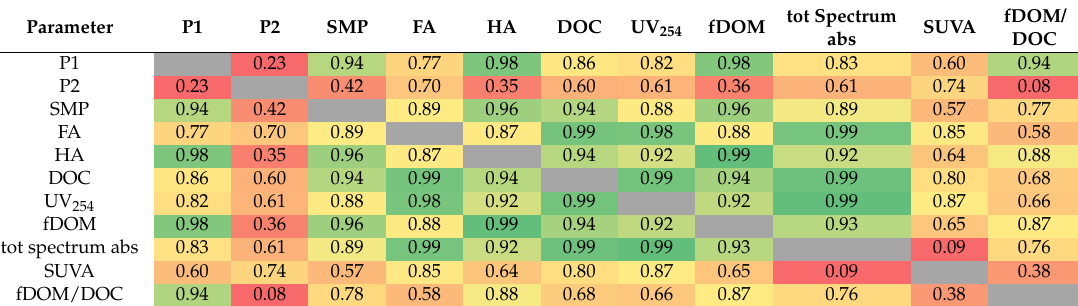
Figure 8. Comparison between ( a ) Relative abundances of DOM fractions; ( b ) fDOM signal; ( c ) UV 254 and UV 456. Table 1. Coefficients of determination for analyzed